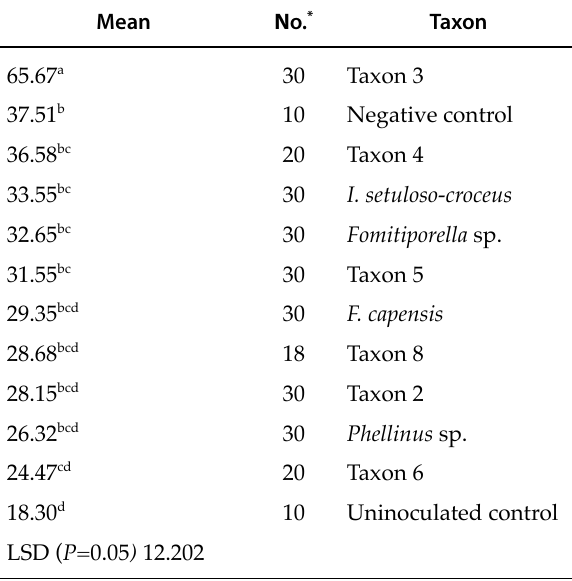
Table 4. Mean (Least Squares) white rot lengths (mm) be- tween different Hymenochaetales taxa inoculated into Shi - raz